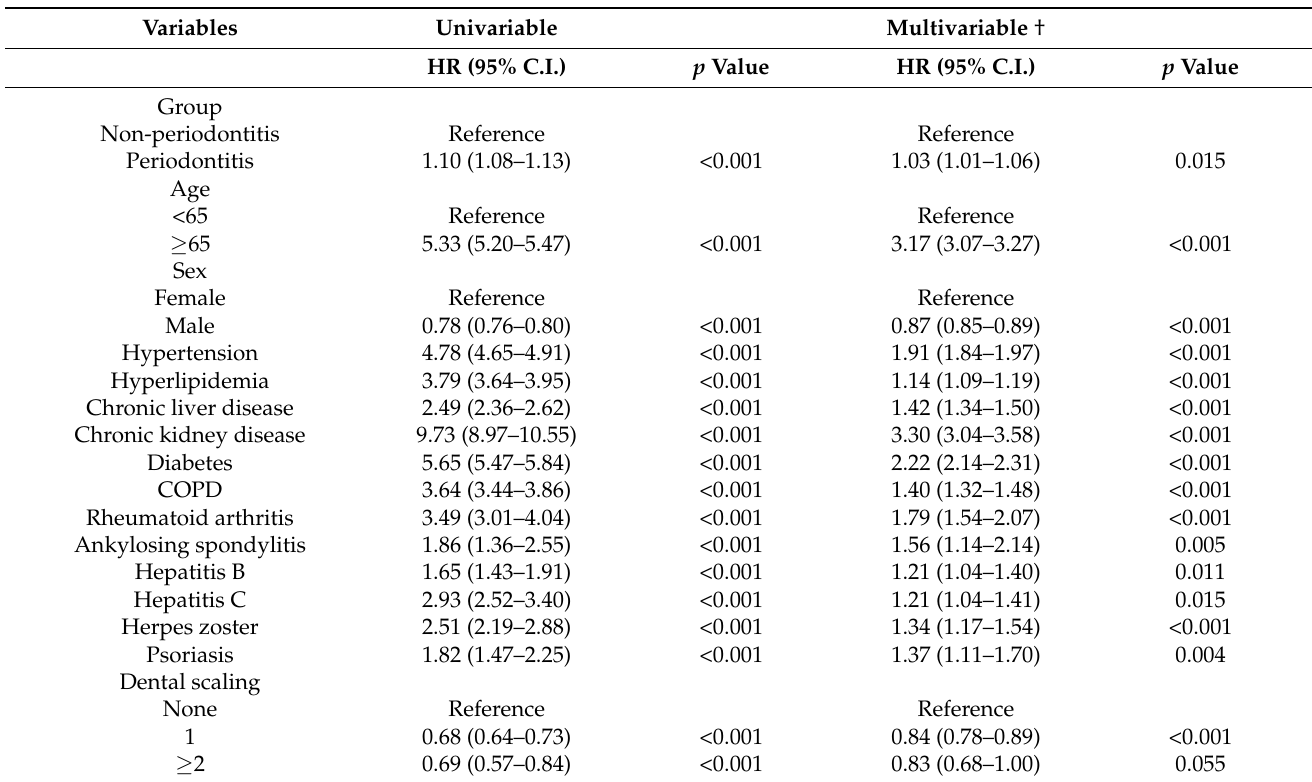
Table 3. Cox proportional hazard model analysis for risk of PAOD.